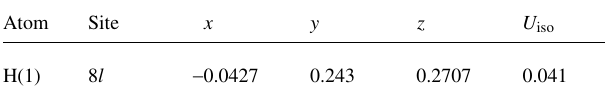
Table 2. Atomic coordinates and displacement parameters (in Å 2 ) .